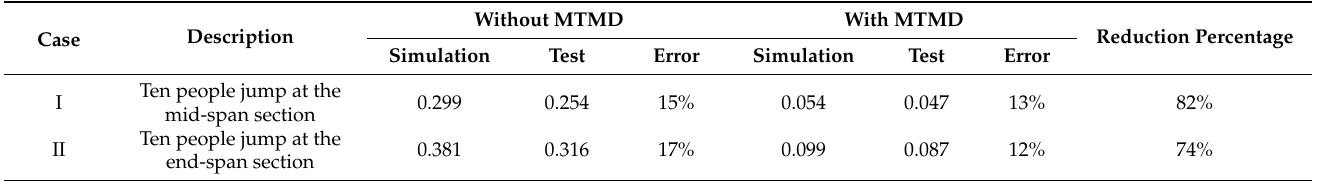
Table 13. Summary of the maximum mid-span accelerations in the two